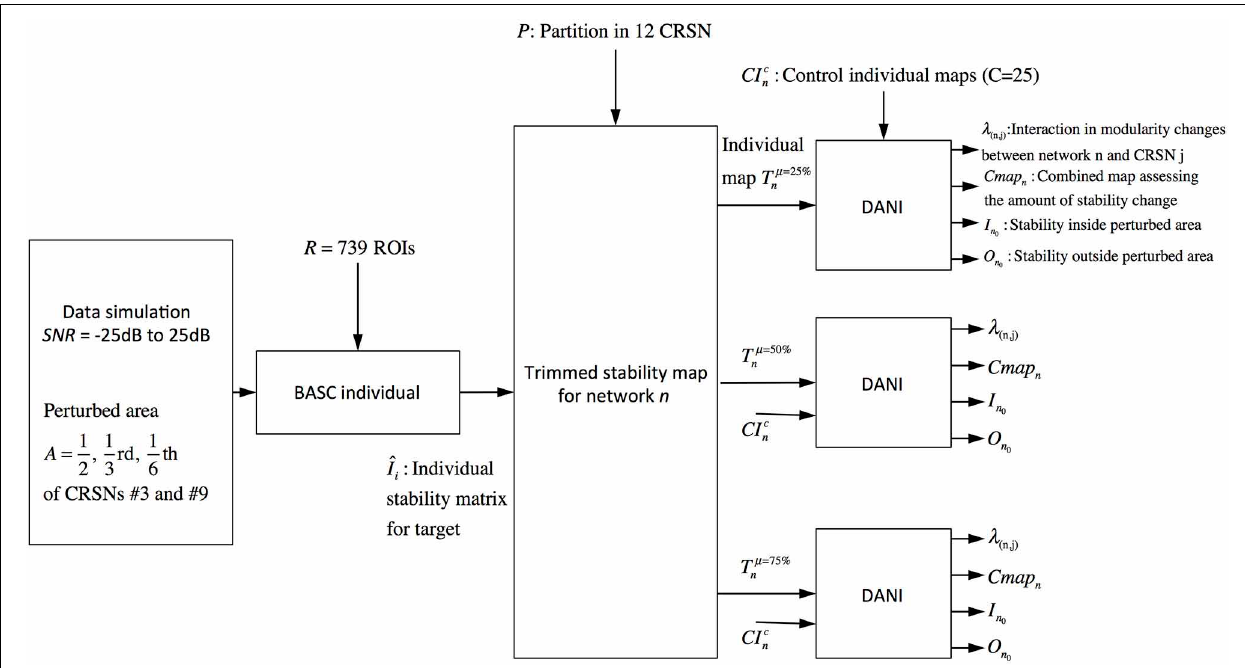
FIGURE 3 | Pipeline summarizing the validation procedure: the input is the preprocessed fMRI data perturbed within a region of size A (A = 1/2, 1/3, and 1/6 of the targeted networks) at a specific SNR dB and the